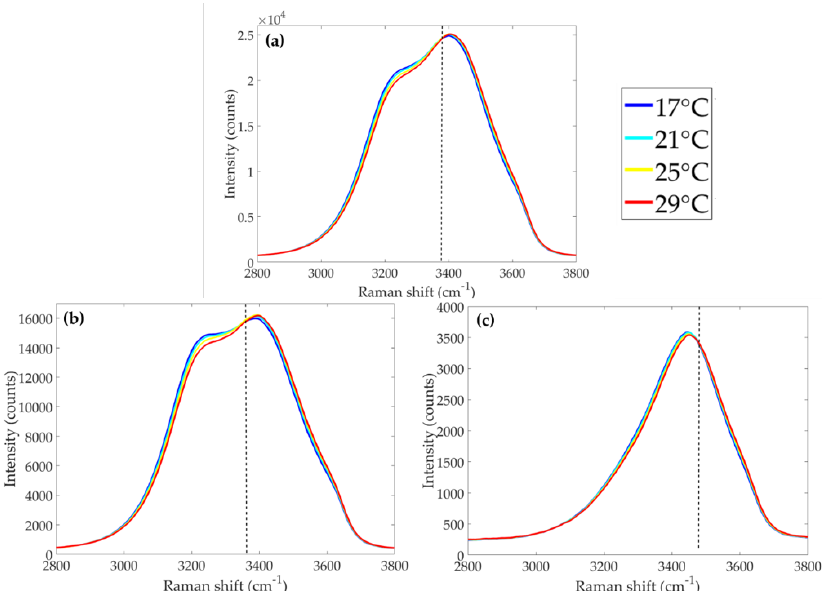
Figure 1. Temperature-dependent Raman spectra from ultrapure (reverse osmosis) water. ( a ) unpolarized spectra; ( b ) parallel-polarized spectra; ( c ) perpendicularly-polarized spectra. Isosbestic points are indicated by a dashed line.